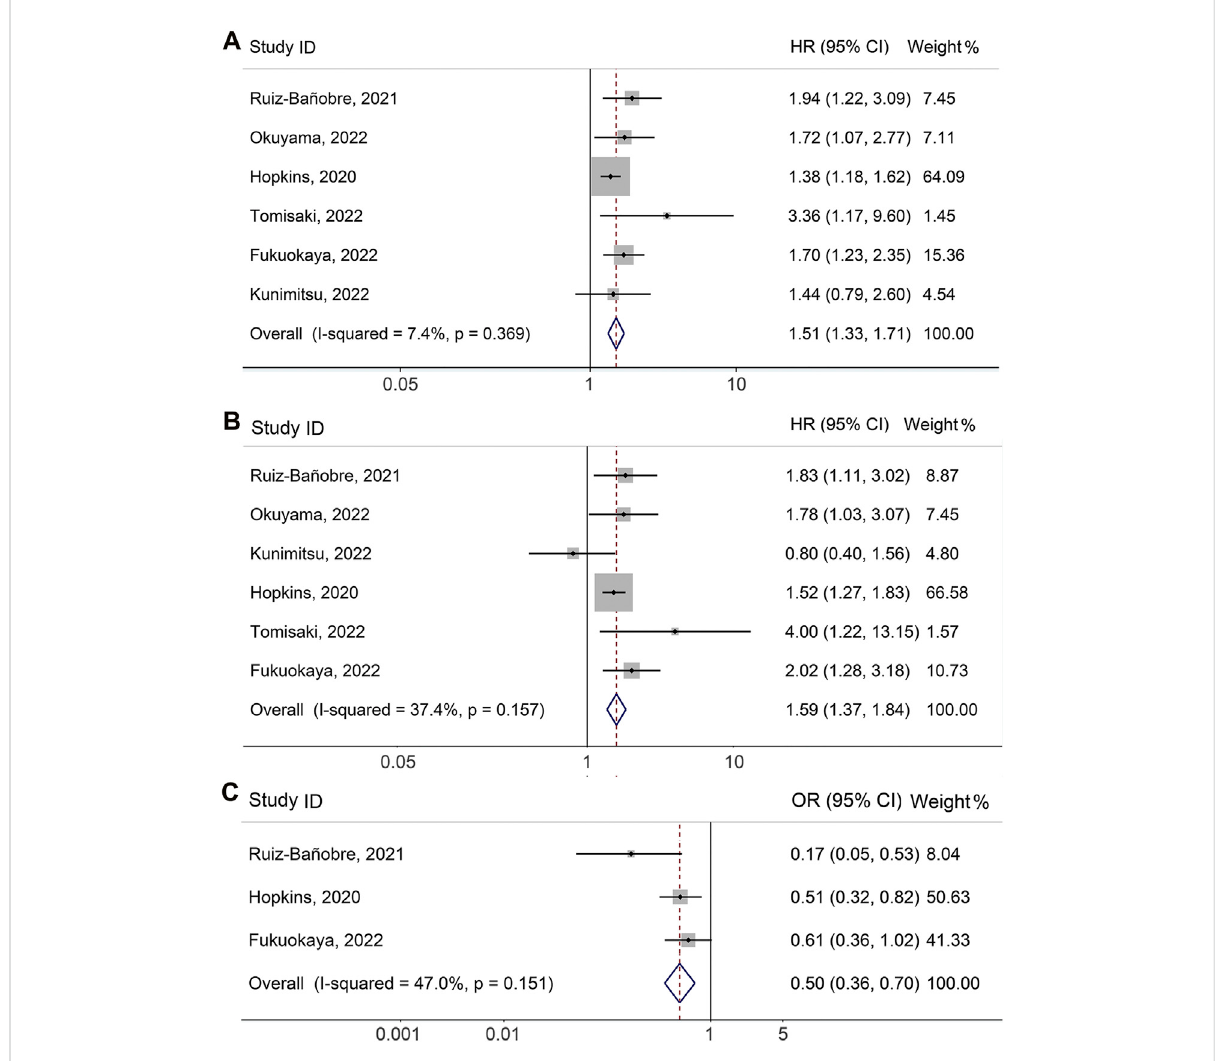
Forestplots ofHRforcorrelationofprotonpumpinhibitorusewithadjustedprogression-freesurvival (A) andoverallsurvival (B) .Forest plotsof OR for correlation of proton pump inhibitor use with adjusted objective response rate (C) . OR, odds ratio; HR, hazard ratio; CL, con fi dence interval.